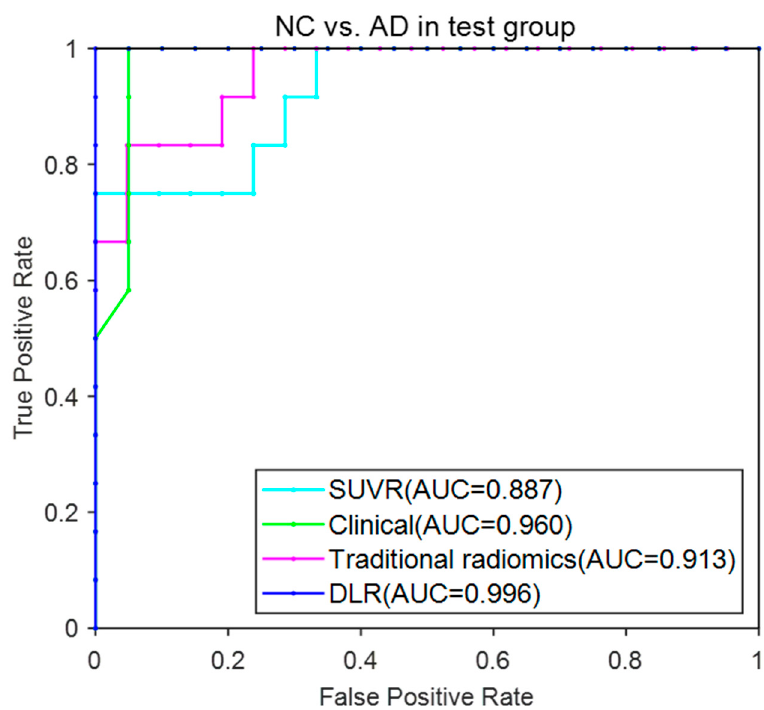
Figure 7. ROC curves for the four models in NC vs. AD.